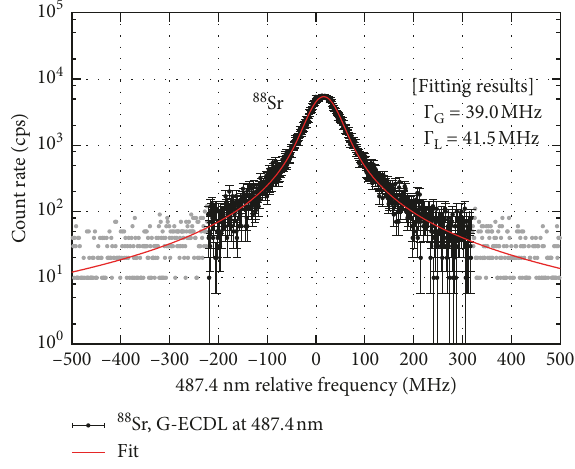
88 Sr, G-ECDL at 487.4nm Figure 3: The Voigt profile of the 88 Sr ion signal with respect to the 487.4 transition laser